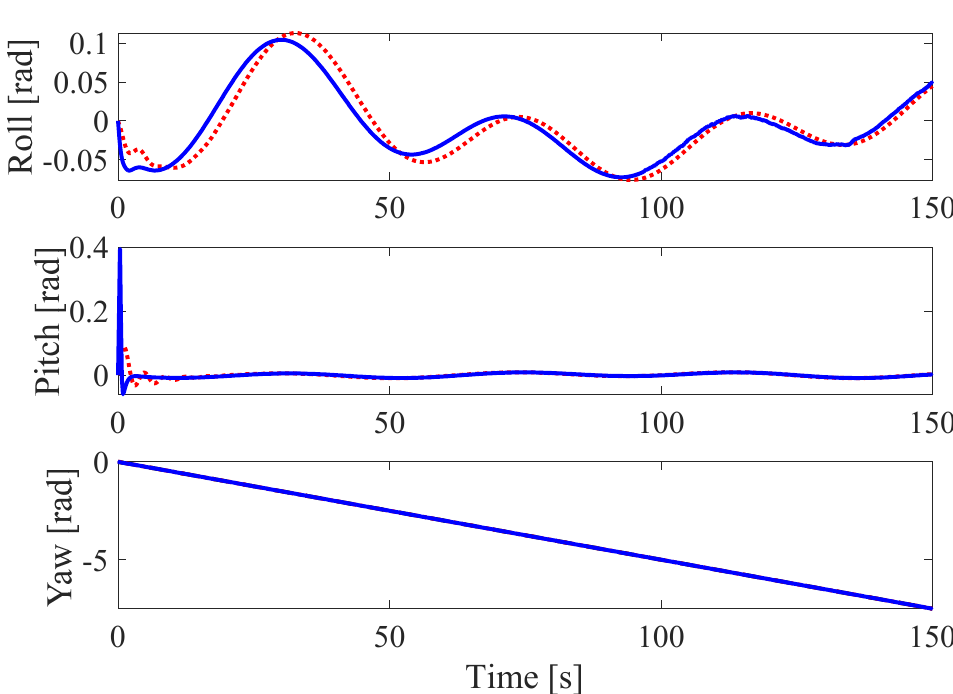
Figure 7. Attitude control response of two motion control systems. The red dotted line is PID control; the solid blue line is SMC; the reference trajectory of the yaw motion is ϕ d = − 0.05 t .